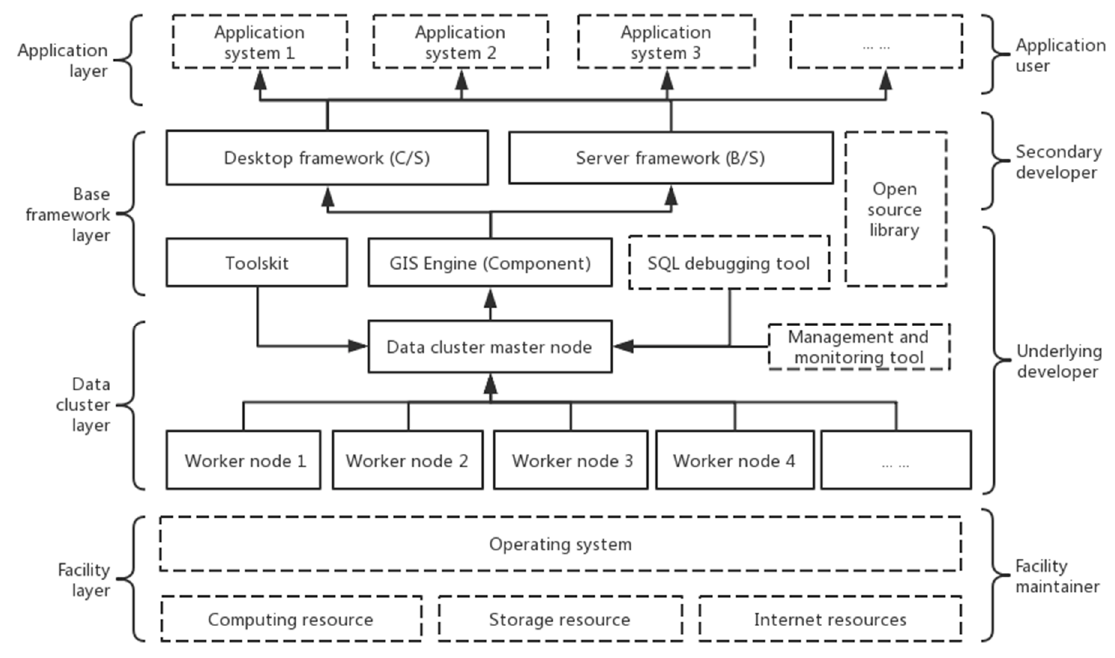
Figure 1. Overall design of BiGeo. BiGeo is a loosely assembled combination of five frames, each with the same technology stack, which can be combined and split at will. Each part of the framework can be used independently or in an extended manner. The solid box in the figure shows the core content of BiGeo, and the dashed box is the relevant support technology or derivative.